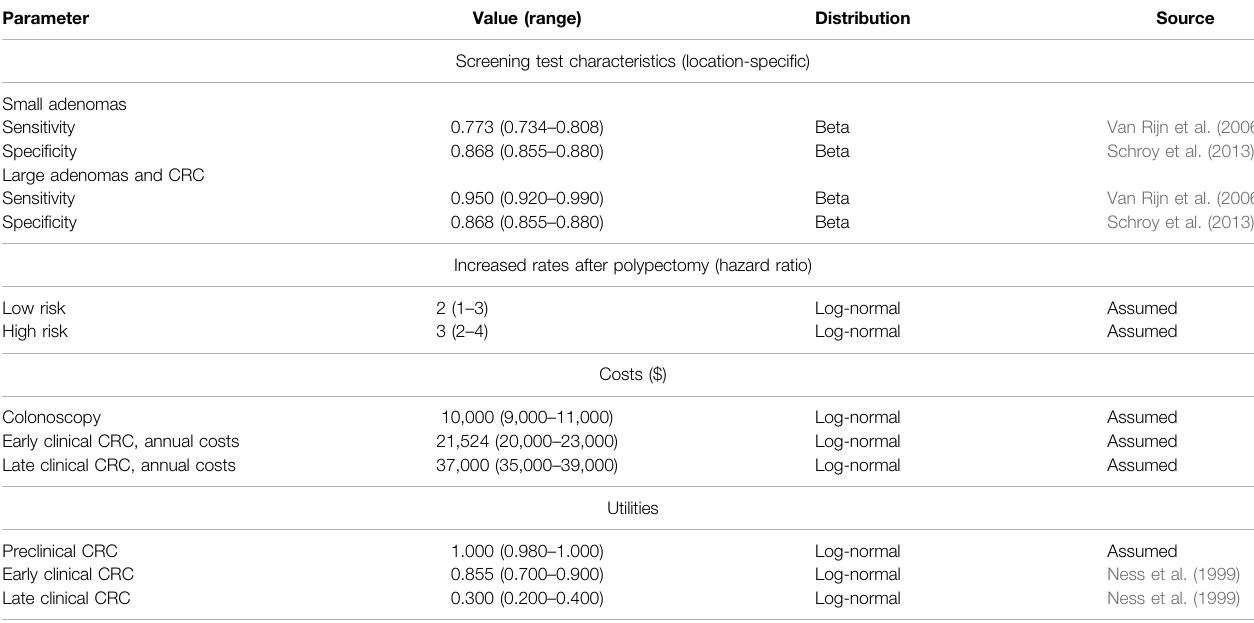
TABLE 2 | Description of cost-effectiveness analysis parameters.